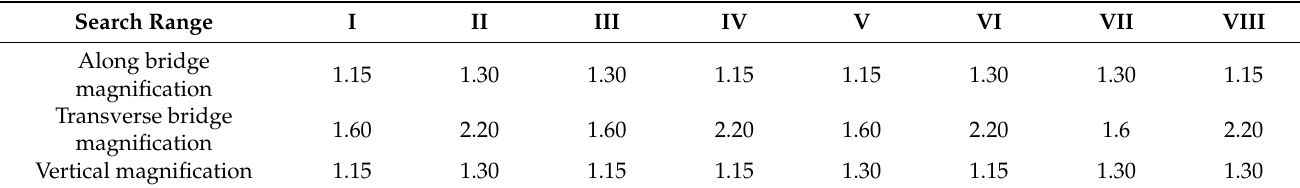
Figure 7. Finite Element Model of Bridge.